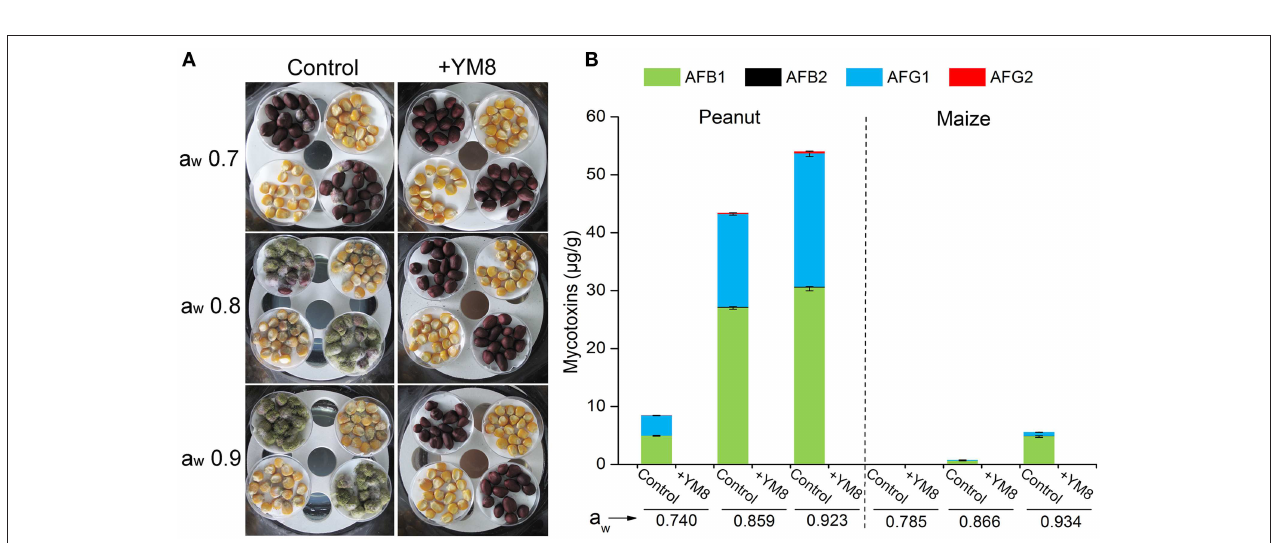
FIGURE 4 | Inhibition effect of six selected VOC compounds on the mycelial growth and conidial germination of Aspergillus flavus . Individual compounds with different concentrations were assayed for their inhibition activity against mycelia and conidia of A. flavus grown on potato dextrose agar for 5 days (mycelia) and 1 days (conidia). Data represent the means ± SE from three measurements.